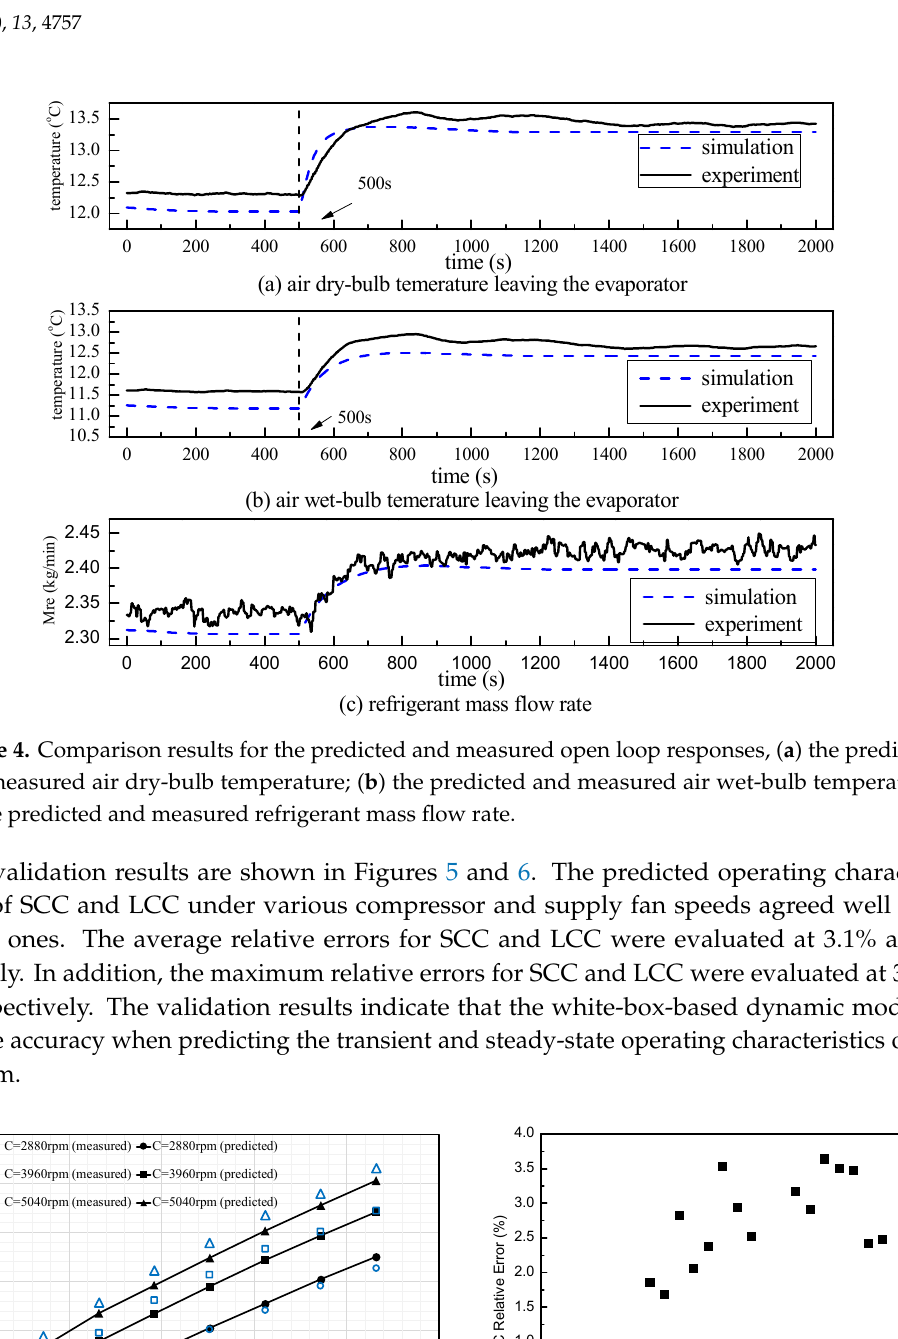
( b ) Figure 6. Comparison results for the measured and predicted values of LCC, ( a ) LCC; ( b ) Relative error. 4. Operating Performance Prediction Under Various Operational Conditions To further investigate the operating performance of the DX A/C system under various operational conditions, more simulation cases, as listed in Table 2, were performed. It should be pointed out that in all simulations the inlet air temperature and humidity were, respectively, fixed at 26 °C and 50%. While different inlet air states would influence the operating performance of the DX A/C system, the general variation trends observed and the related analysis should remain valid. Table 2. The simulation range of compressor and supply fan speeds. Percent of Max Speed